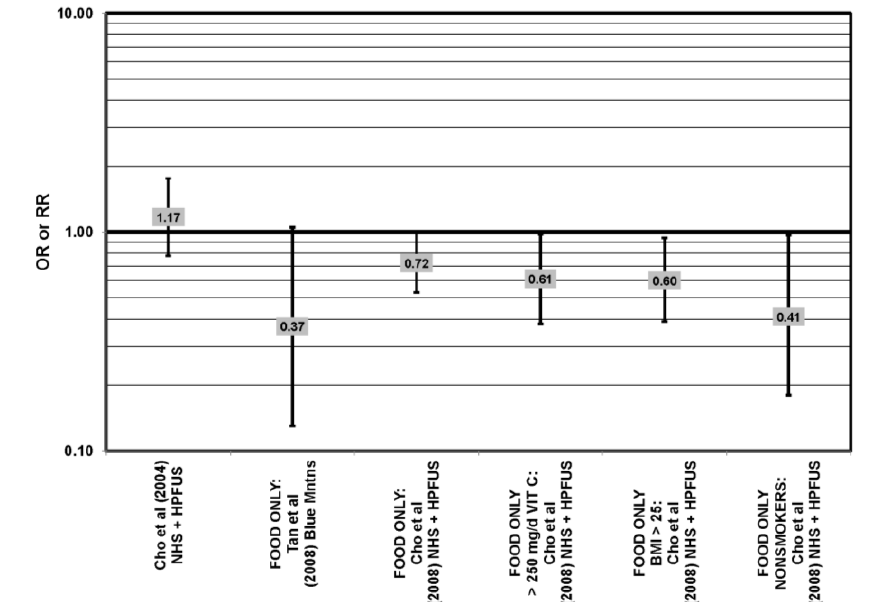
Figure 32. Neovascular AMD odds or risk ratio; high vs. low intake of lutein and zeaxanthin: prospective studies.